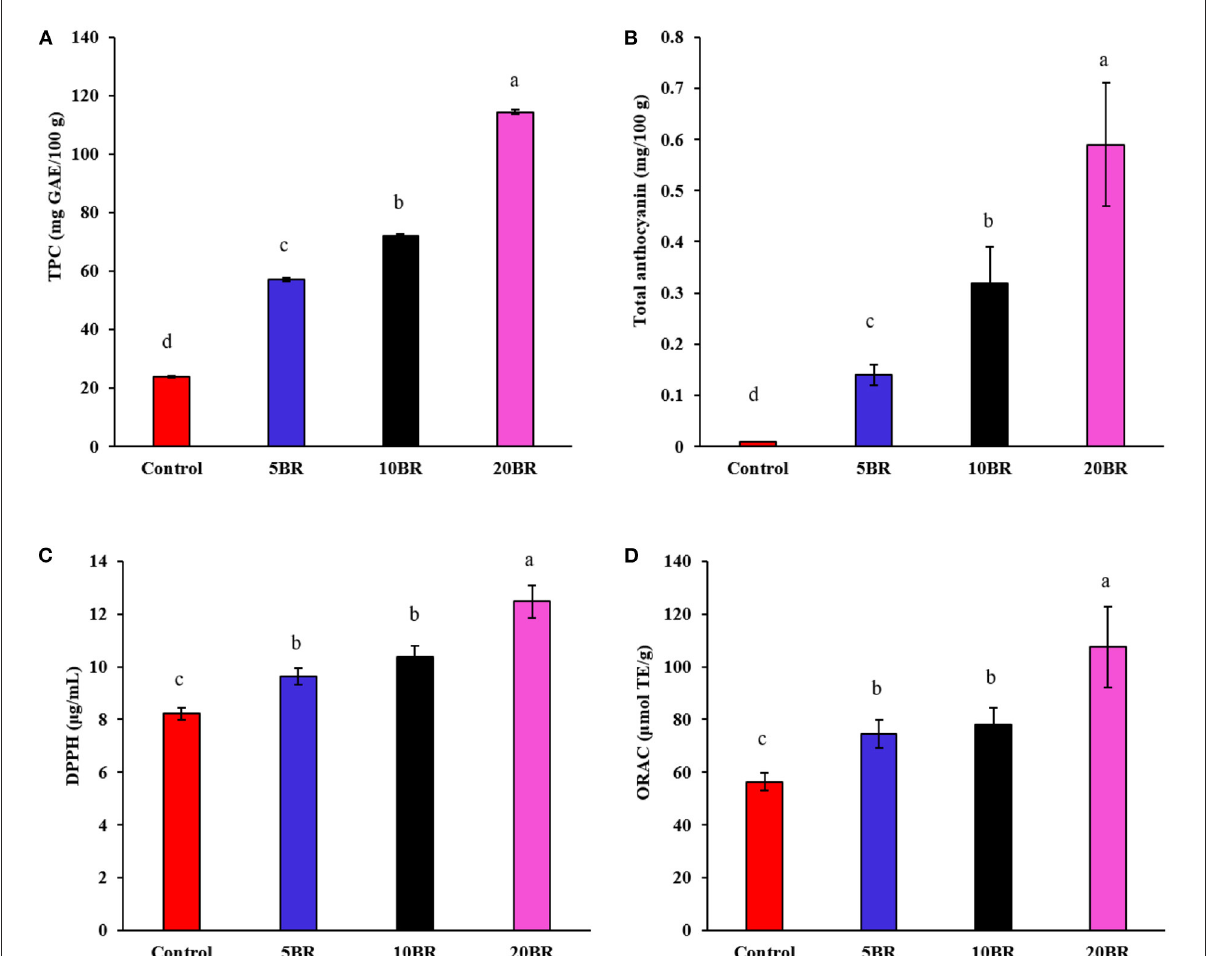
FIGURE3 The in vitro antioxidant capacity of flaky rolls incorporated with different proportions of black rice flour: (A) total phenolic content; (B) total anthocyanin; (C) DPPH scavenging activities; and (D) ORAC assays. Different letters significantly represent difference ( P < 0.05) from the